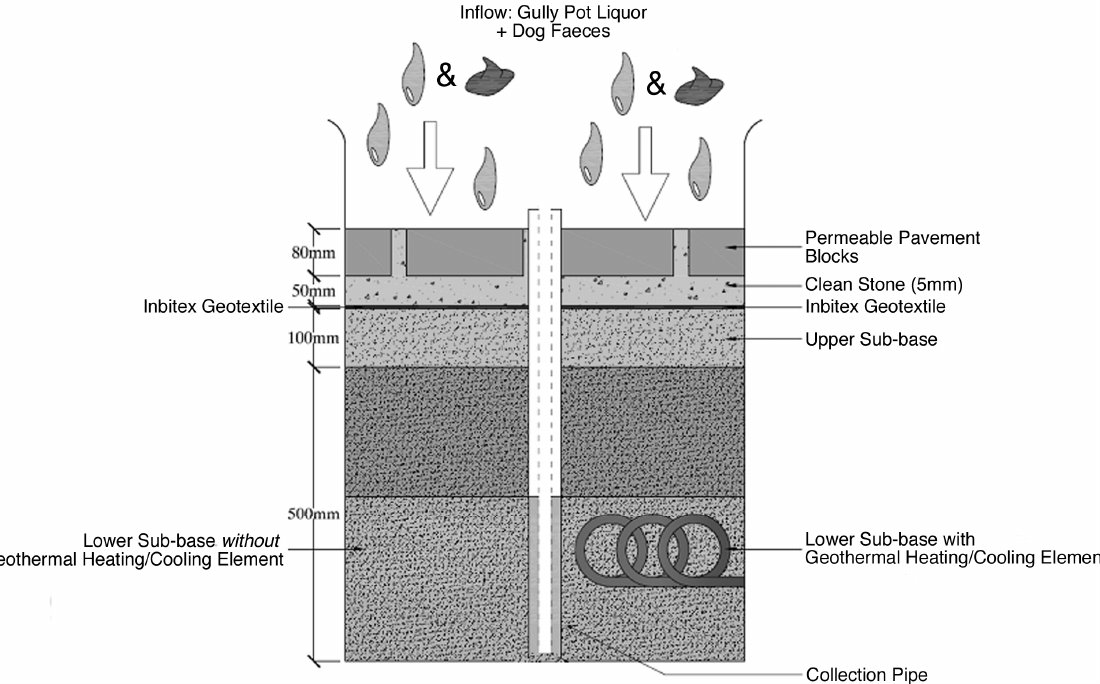
Figure 3. Schematic outline of the main design principles of an experimental permeable pavement set-up without and with a geothermal system used in the “Edinburgh study” (after [10]).